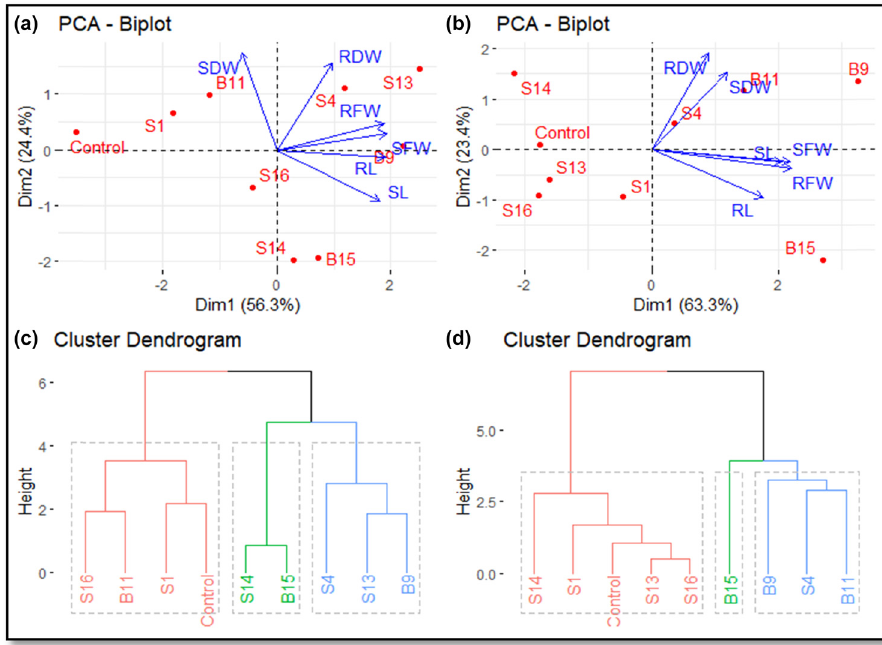
Figure 6: E ff ect of bacterial treatments on growth parameters of tomato seedlings on sterilized soil. ( a and b ) PCA of Raja ( a ) and Foolewouh ( b ) varieties. ( c and d ) HAC of individuals for Raja ( c ) and Foolewouh ( d ) varieties. SL – stem length; RL – root length; RFW – root fresh weight; RDW – root dry weight; SFW – stem fresh weight; RDW – root dry